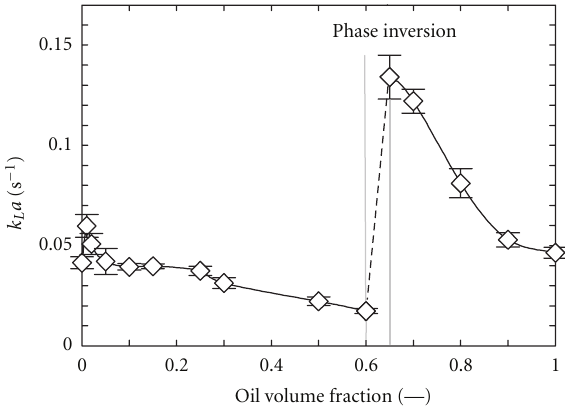
ff ect of n-dodecane volume fraction on k